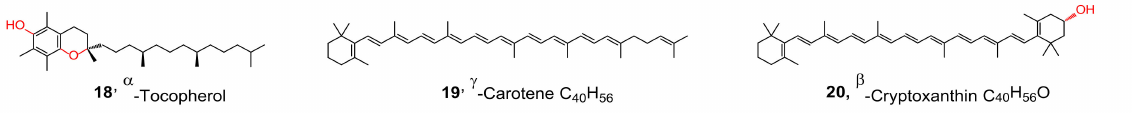
Figure 2. Structures of carotenoids and